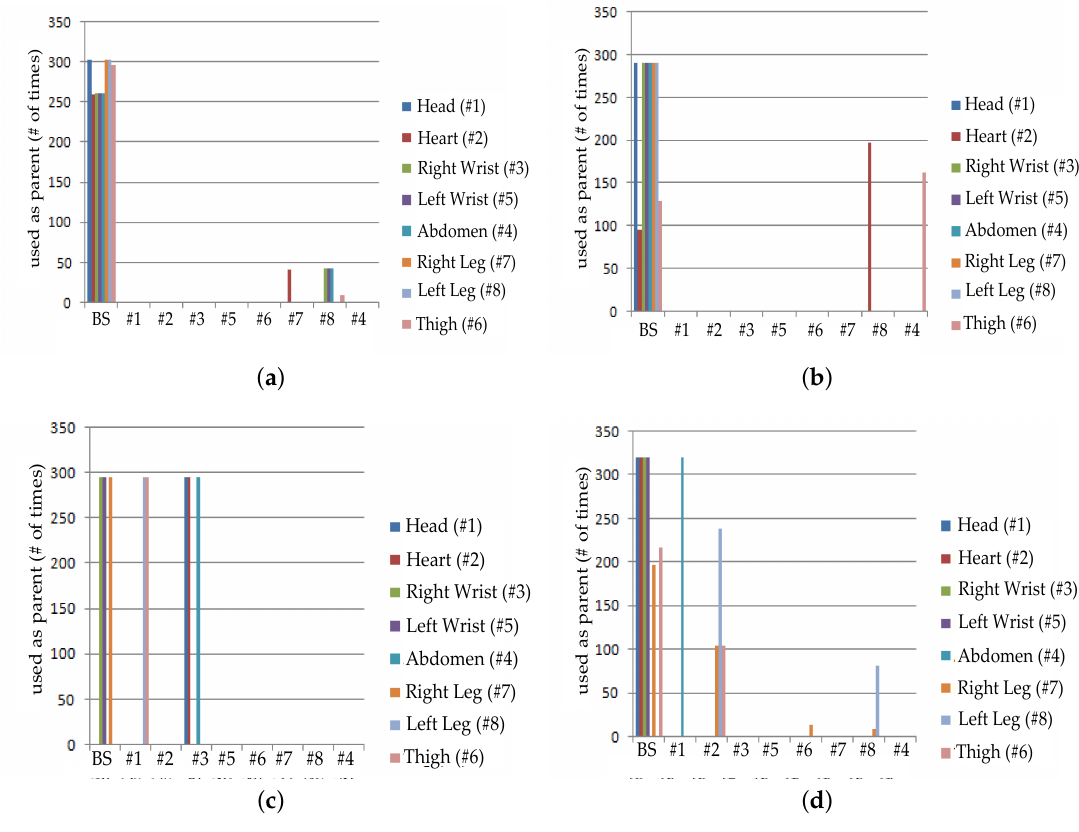
Figure 10. No. of hops while walking activity. ( a ) At TX 1 ; ( b ) At TX 2 ; ( c ) At TX 3 ; ( d ) At TX 4 .